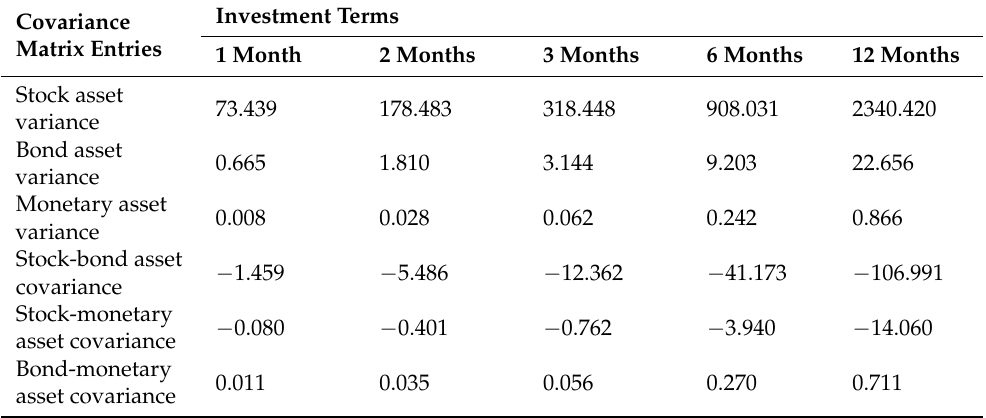
Table 2. The sample covariance matrices of stock, bond, and monetary assets under different terms.